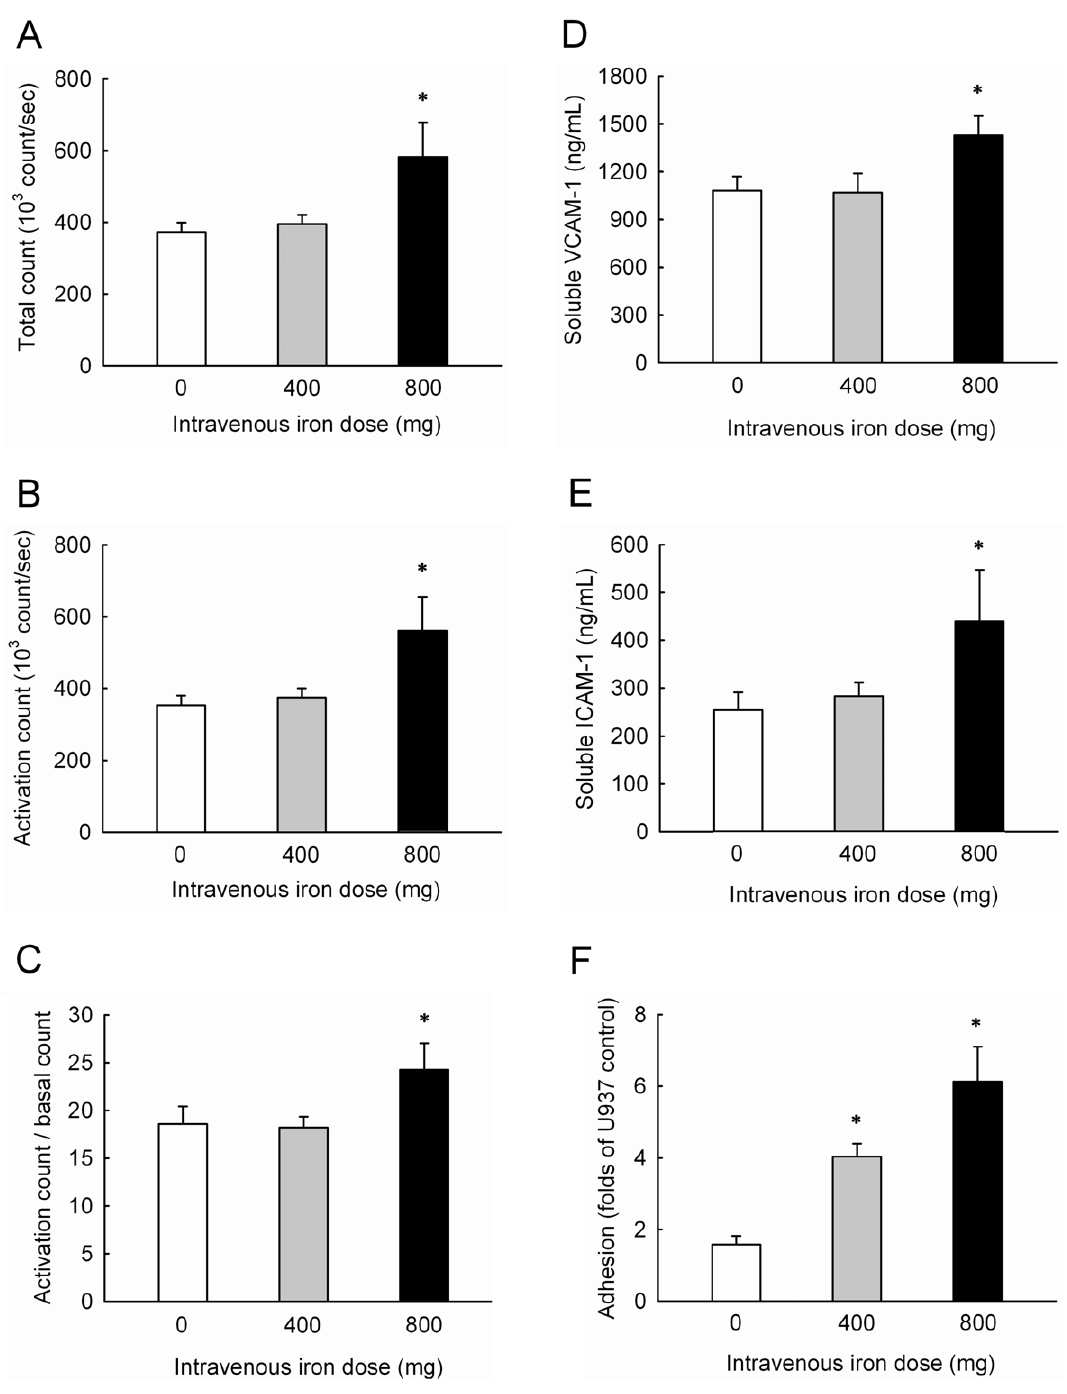
Figure 2. IV iron significantly increased superoxide production and endothelial damage invivo . Total (A) and activated (B) intracellular production of superoxide, the ratio of activated to total superoxide (C) in circulating MNCs, plasma levels of VCAM-1 (D) and ICAM-1 (E), and endothelial adhesiveness of circulating MNCs (F) in hemodialysis patients. All patients were randomly allocated into 3 groups according to the IV Atofen iron doses of 0 mg (n = 20), 400 mg (n = 20), and 800 mg (n = 20). * P , 0.05 compared with patients not receiving IV iron therapy. Abbreviations: ICAM-1, intracellular cell adhesion molecule-1; VCAM-1, vascular cell adhesion molecule-1.